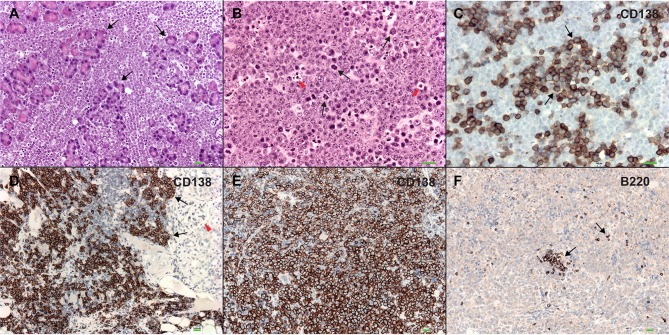
Plasmablastic plasmacytomas in Cd19 Wwox KO mice. (A) Microphotograph of plasmablastic plasmacytoma from a Cd19 Wwox KO mouse infiltrating pancreas, magnification 10x with H&E staining. Note how pancreatic tissue architecture is totally destroyed and replaced by infiltrating plasmacytoma cells. Black arrows point to pancreatic acinar cells. (B) Plasmacytoma cells infiltrating para-pancreatic lymph nodes of the same case as in (A). Black arrows point to some of multiple mitoses, red arrowheads point to apoptotic bodies. Magnification 20x, H&E staining. (C) Anti-CD138 immunostaining of tumor shown in (B). Black arrows point to CD138 positive (brown) cells. As previously described not all plasmacytoma plasmablast cells stain with anti-CD138 antibody (36). Magnification 20x, counterstained with light hematoxylin. (D) Heavy CD138+ cells infiltrate in kidney from another Cd19 Wwox KO mouse, red arrowhead points to glomerulus. (E) Anti-CD138 immunostaining of spleen from a different Cd19 Wwox KO mouse to those shown in (A–D). Note that most cells are positive for the CD138+ plasma cell surface marker (brown stained cells). (F) Same spleen sample as in (E) immunostained with anti-B220 (CD45R), as can be observed very few scattered cells are positive for this B lymphocyte marker (black arrows). Both of the mice (represented in D–F) displayed M spikes in SPEP analyses. Microphotographs (D–F) taken at 10x, light hematoxylin counterstaining. Horizontal green bars at lower right corner of each photograph represent 100 μm scale.